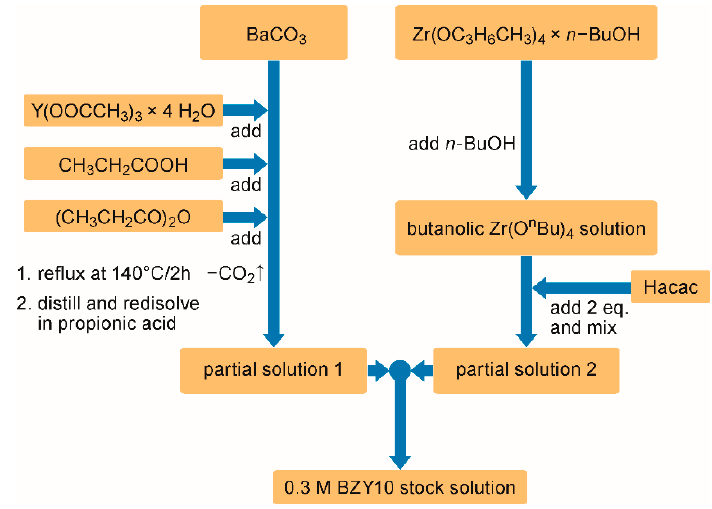
Figure 1. Flow chart of the propionate based conventional BZY10 solution synthesis.